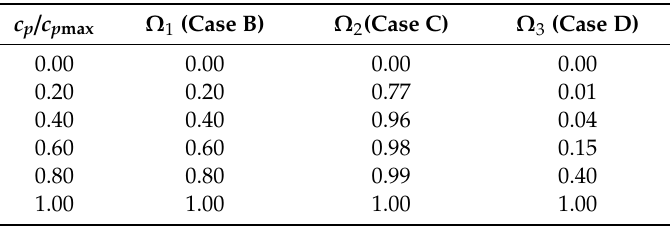
Table 4. The interpolation factor in the case